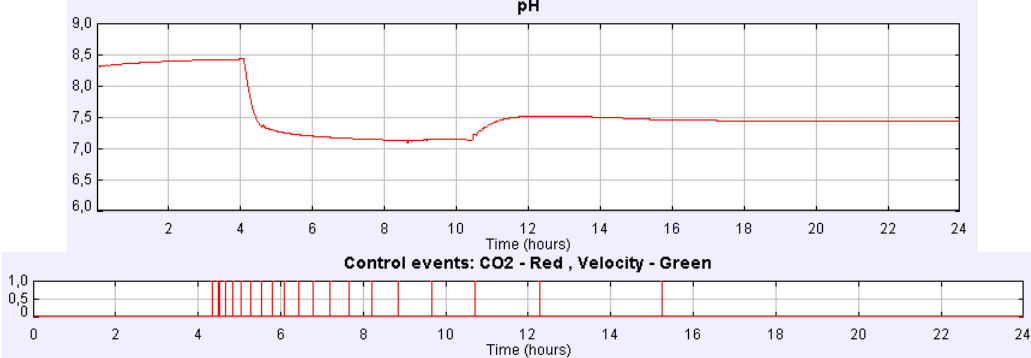
Figure 9. pH and controller signals evolution for the CO event-based